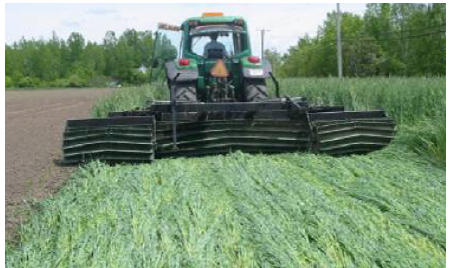
Figure 1. Adaptation of the roller ‐ crimper by the Dewavrin brothers in Les Cèdres, Québec. Reproduced with permission from Estevez, 2008 [13]. Plans are available online for free [31].